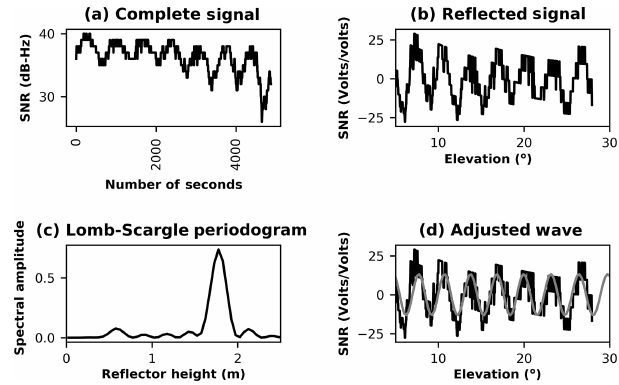
Figure 8. GLONASS satellite no. 5 observed with the mass-market antenna. SNR data in volts (a) , SNR data with the direct signal re- moved (b) , Lomb–Scargle periodogram for the SNR reflected sig- nal (c) , and SNR reflected signal with the adjusted wave (d) .